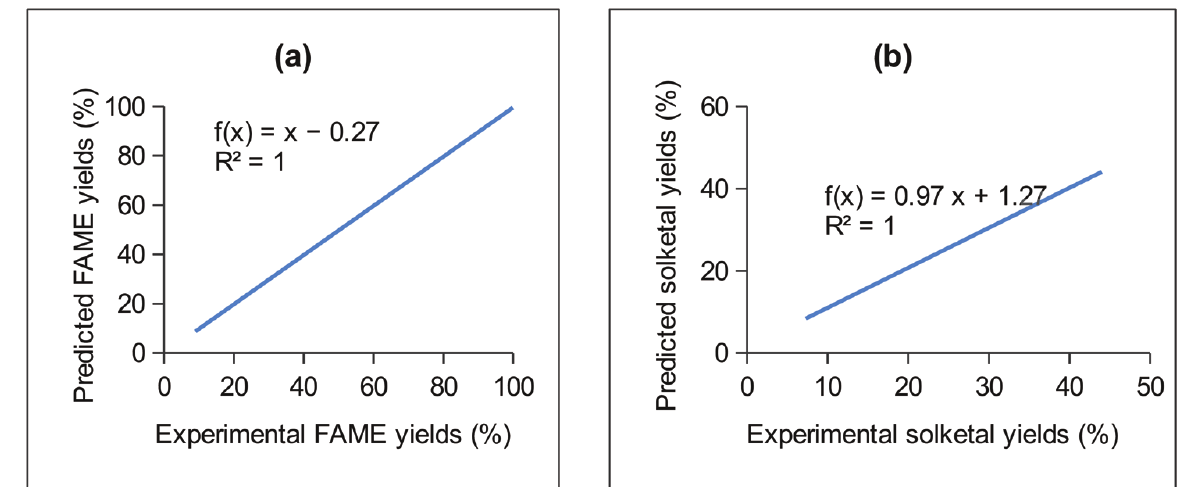
Figure 2: Plots of the experimental versus predicted values for (a) FAME and (b) solketal, for the DoE parametric screening of reaction variables in a single-stage reactive coupling of RSO conversions to FAME and